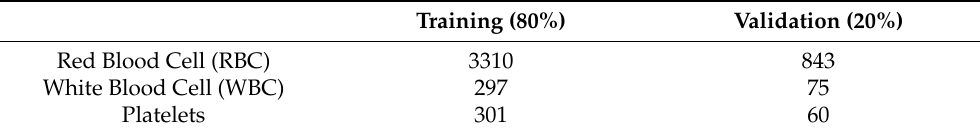
Table 1. BCCD dataset.